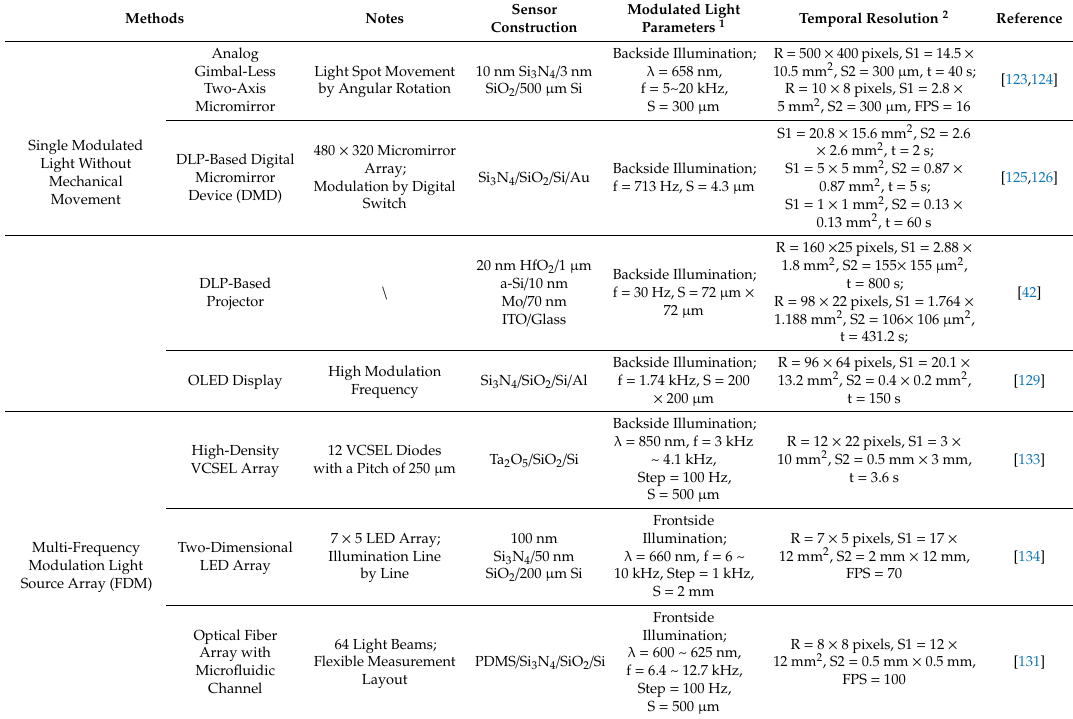
Figure 7. ( a ) Schematic of the LAPS with microfluidic channel set-up; ( b ) The 64 light beams guided by the optical fibers above the LAPS surface; ( c ) Injection of 10 mM NaOH and ( d ) 10 mM HCl into PBS solution. Reprinted (adapted) with permission from Miyamoto et al. [131] Copyright (2019) Elsevier. Table 3. Technical information about improving the temporal resolution of